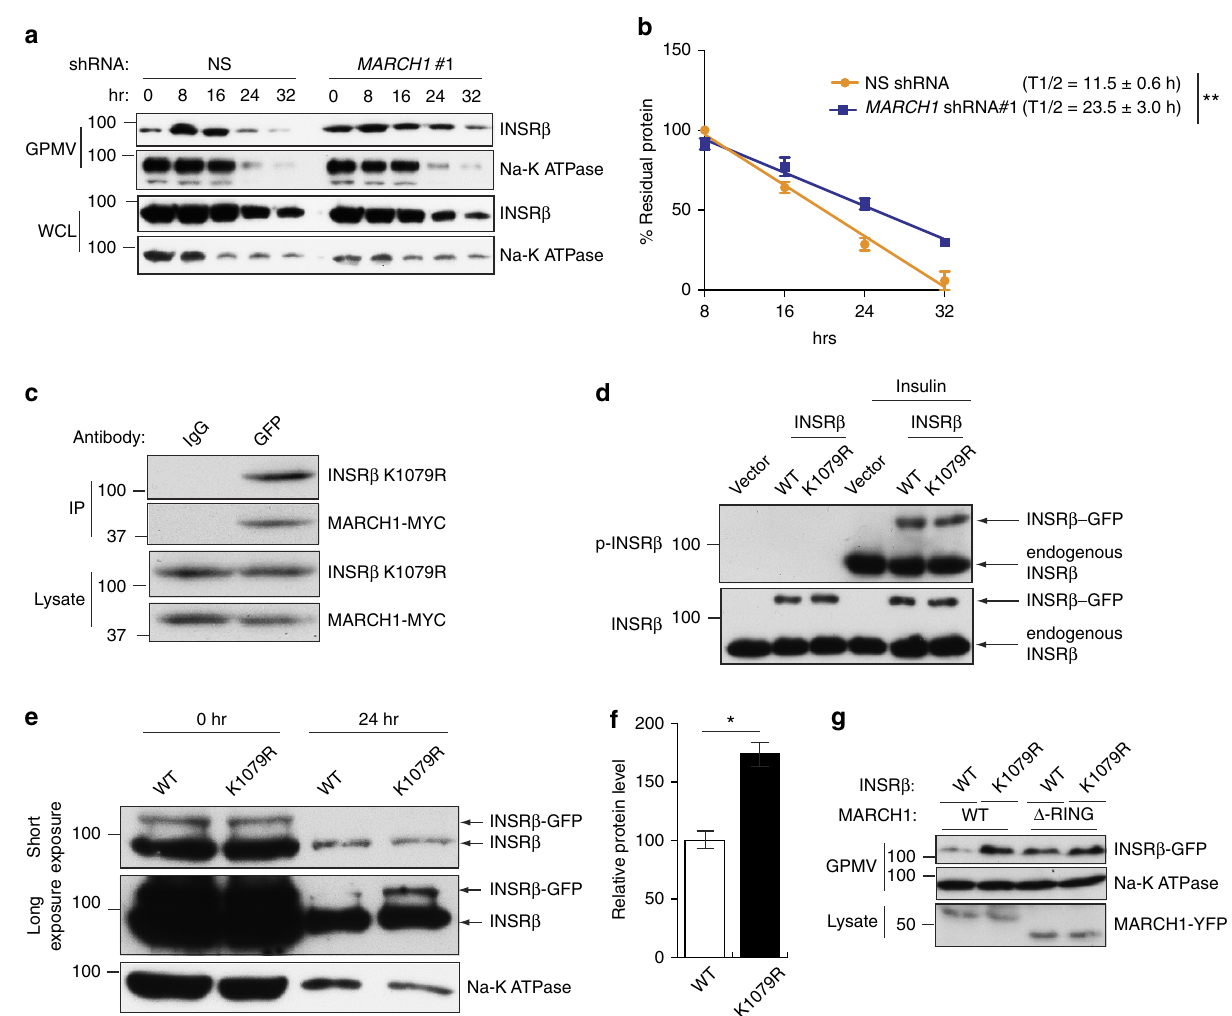
Figure 9 | MARCH1 ubiquitination of INSR b Lys 1079 controls INSR b membrane stability. ( a ) Surface INSR b content in GPMVs from HeLa cells expressing the indicated shRNAs and treated with cycloheximide (see also Supplementary Fig. 7a). ( b ) Analysis of surface INSR b half-life, normalized to Na-K ATPase intensity ( n ¼ 3). ( c ) Co-immunoprecipitation of INSR b K1079R-GFP and MARCH1-MYC from HeLa cells expressing both proteins. ( d ) Immunoblot analysis of INSR b phosphorylation in HeLa cells expressing vector, INSR-GFP WTor INSR K1079R-GFP with or without insulin stimulation. ( e ) Immunoblot analysis of INSR b and Na-K ATPase surface stability in GPMVs of HeLa cells expressing wild-type or K1079R INSR and treated with cycloheximide. Short (top) and long (middle) exposures of INSR b blots are shown. ( f ) Densitometric quantitation ( n ¼ 3) of bands labelled as INSR b -GFP in e . ( g ) HeLa cells were transfected with wild-type or K1079R mutant INSR-GFP and either wild-type or D RING MARCH1-YFP constructs. GPMVs were analysed for INSR b and Na-K ATPase and lysates were analysed for MARCH1-YFP by immmunoblot analysis. Data are mean ± s.e.m. In ( e ), n ¼ 3 biological replicates. In all panels, * P o 0.05, comparisons by t